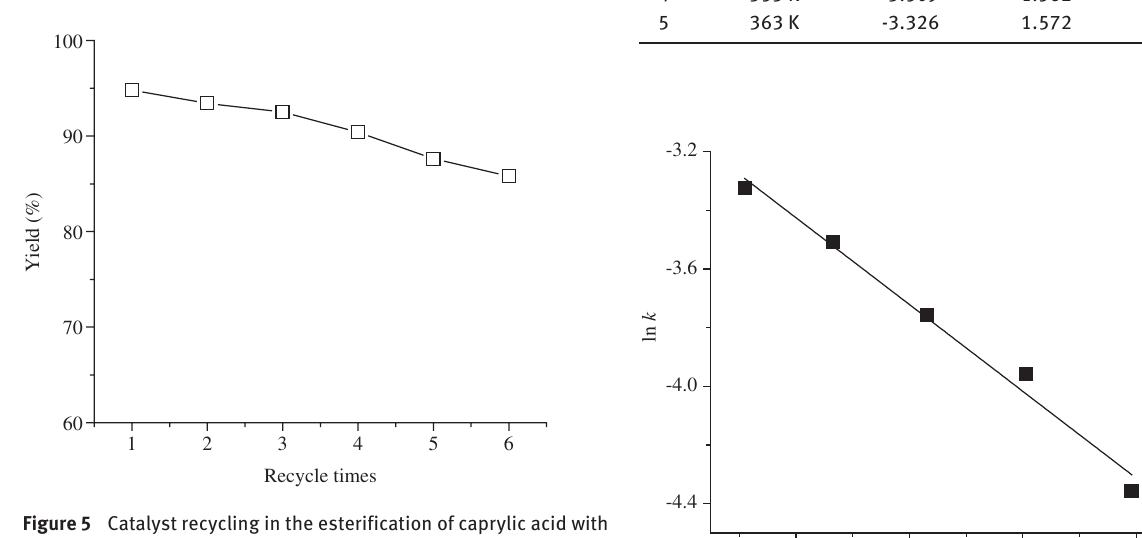
Figure 6 Arrhenius plot of ln k versus 1/